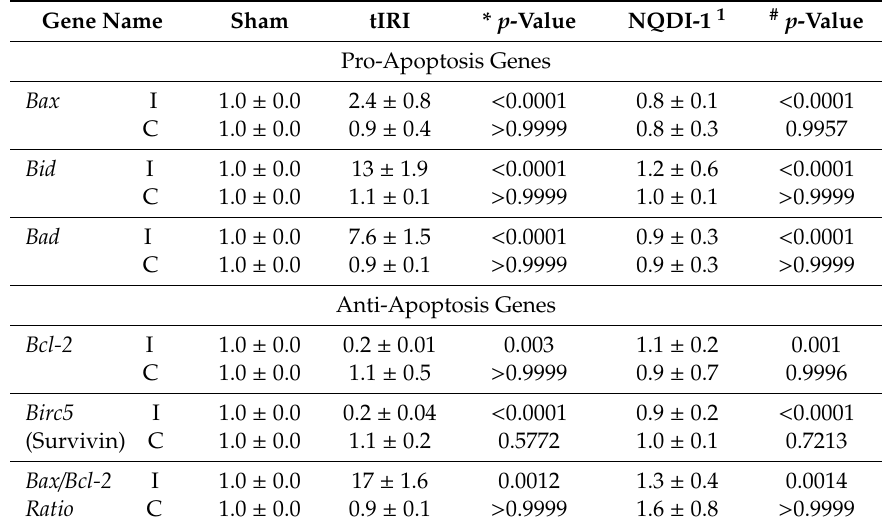
Table 1. Relative mRNA expression of apoptosis-related genes calculated by the 2 − ∆∆ CT formula.